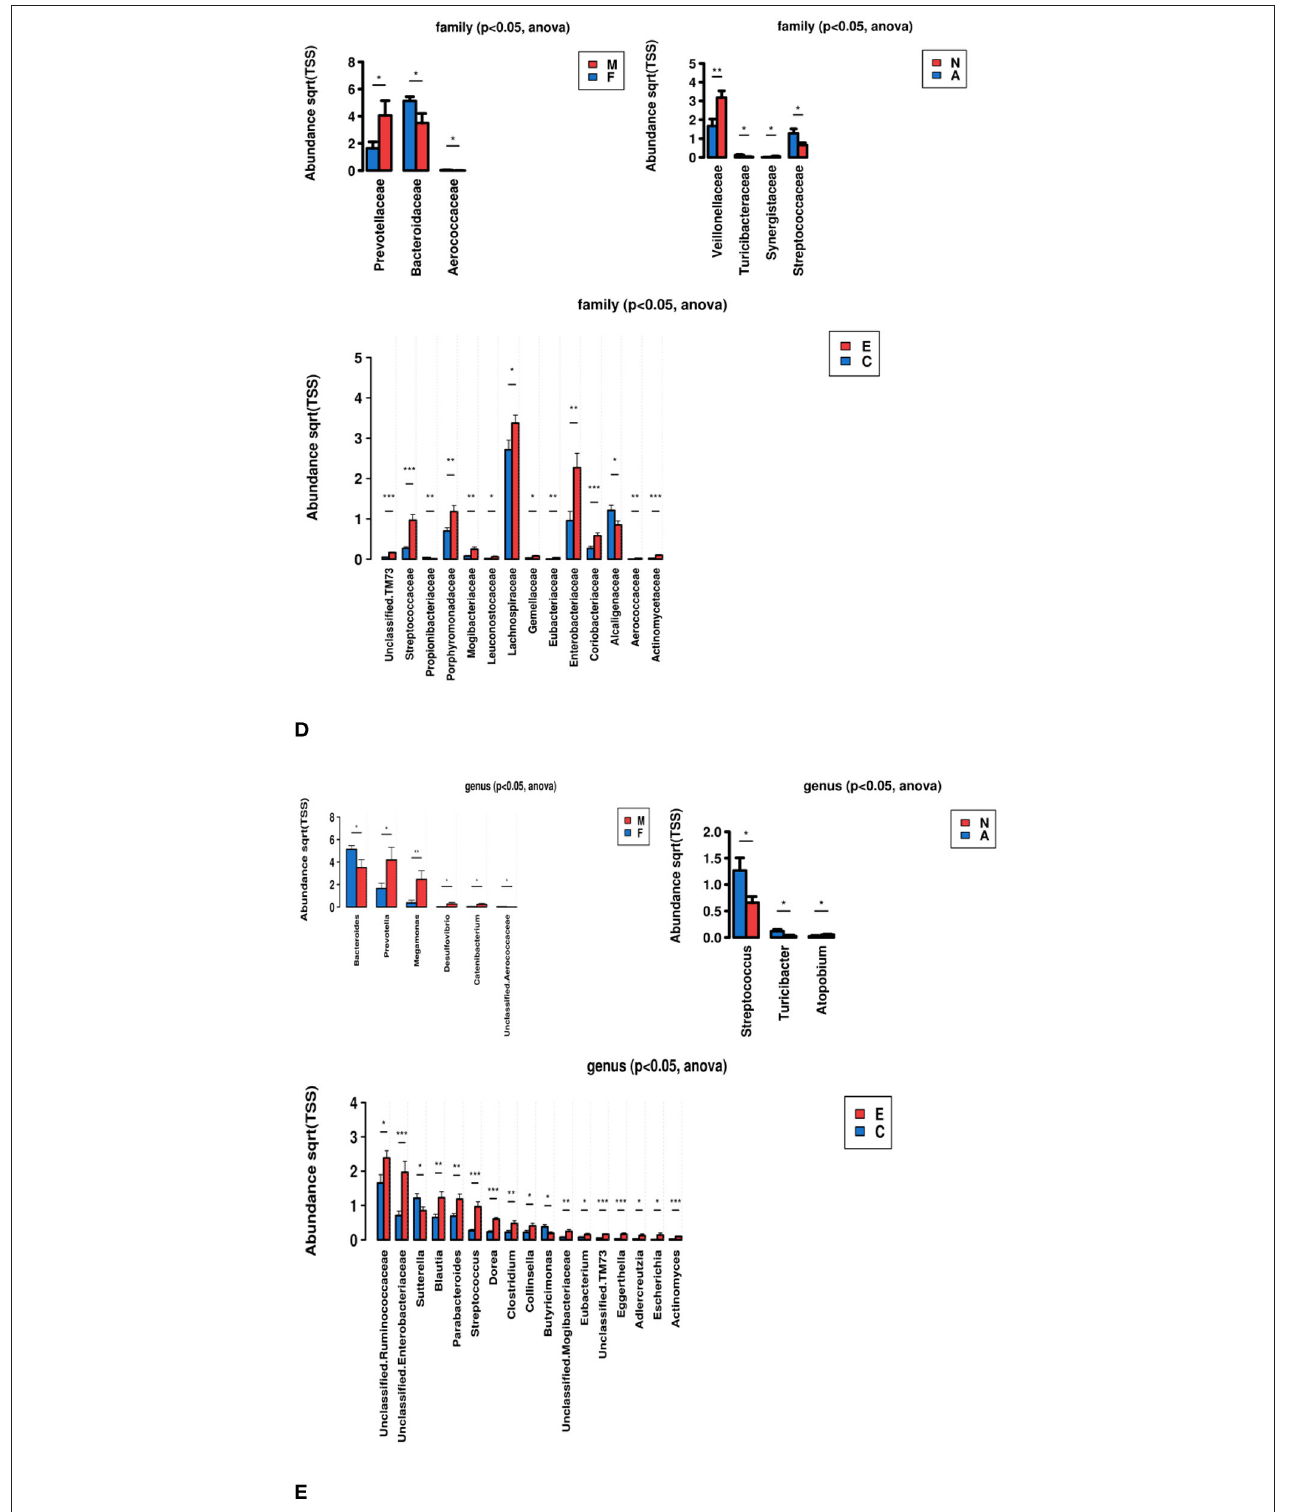
FIGURE 4 | Identify bacteria with significant differences by comparative analysis between two groups (* p < 0.05, ** p < 0.01, *** p < 0.001). (A) Phylum, (B) Class, (C) Order, (D) Family, (E) Genus.